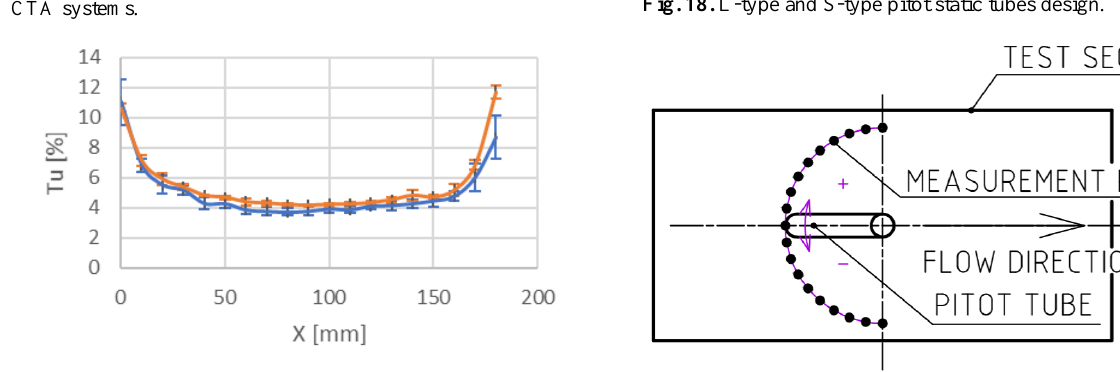
Fig. 19. L-type and S-type pitot static tube experimental setup